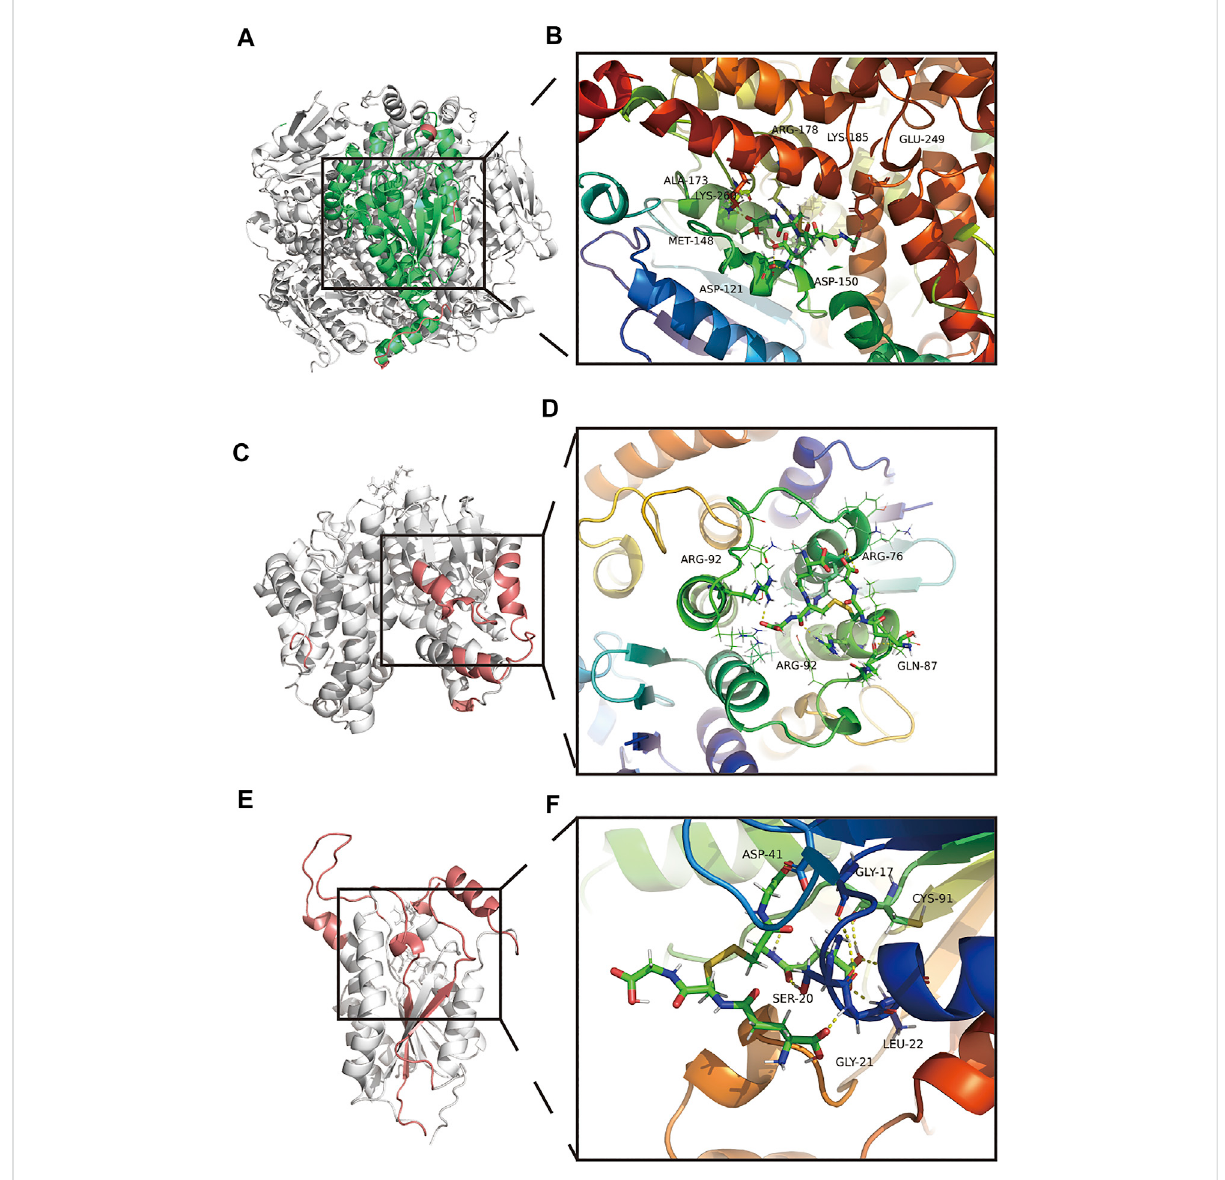
FIGURE 7 Aminoacidinteractionsofthestablestructure. (A,B) AminoacidinteractionsofGSSG-ECSH1complexMDSafterobtainingthestablestructure. (C,D) Amino acid interactions of GSSG-GSTT1 complex MDS after obtaining the stable structure. (E,F) Amino acid interactions of GSSG-HSD17B10 complex MDS after obtaining the stable